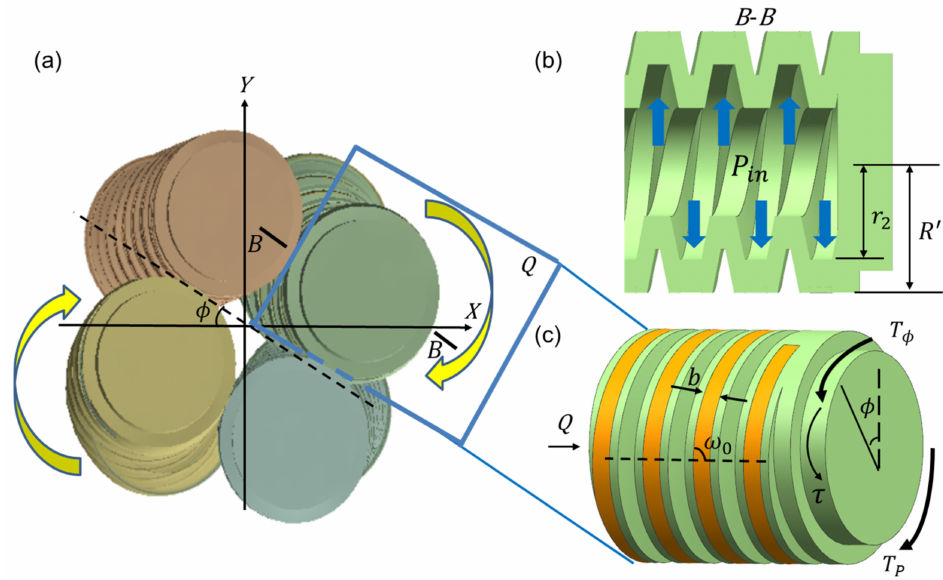
Figure 4. Twisting model of the soft wrist: ( a ) twisting of four actuators; ( b ) longitudinal section of a pressured actuator; ( c ) shear model of a pressured